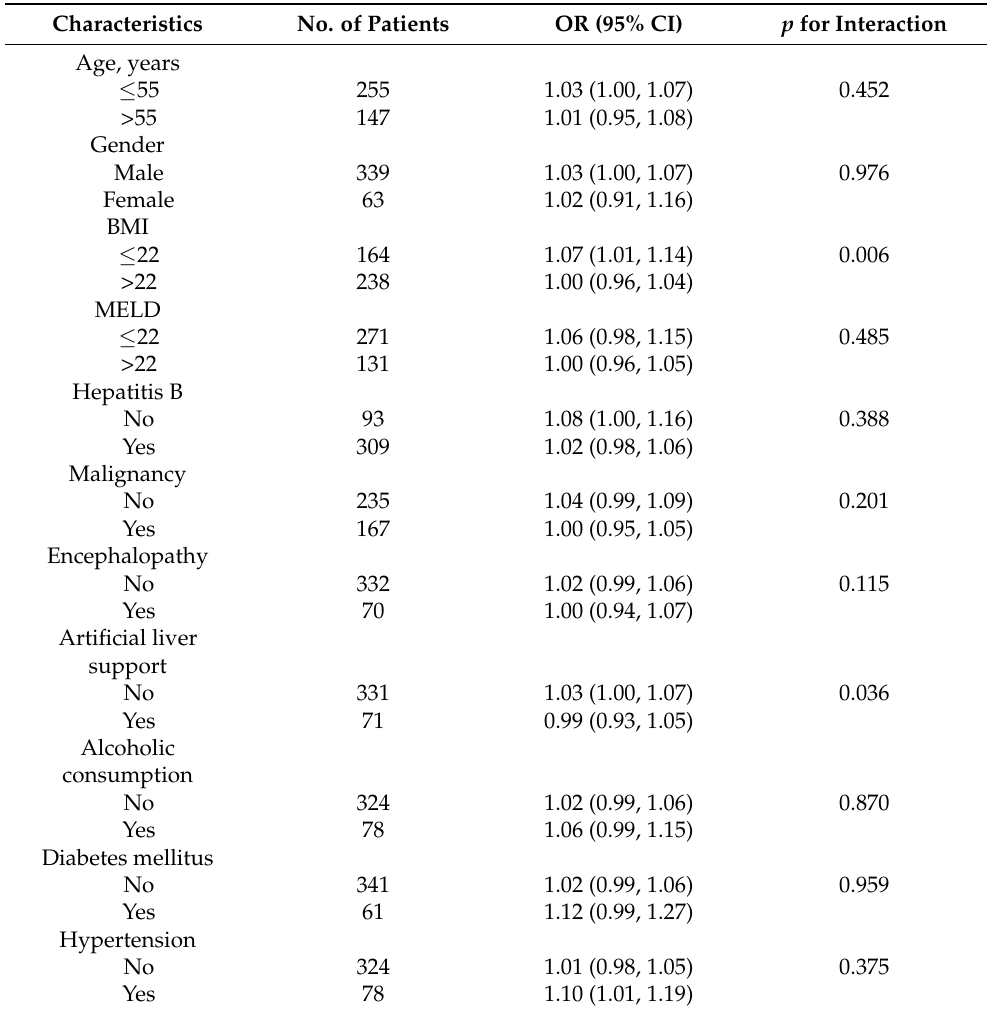
Table 5. Effect size of preoperative total bilirubin on postoperative delirium in prespecified and exploratory